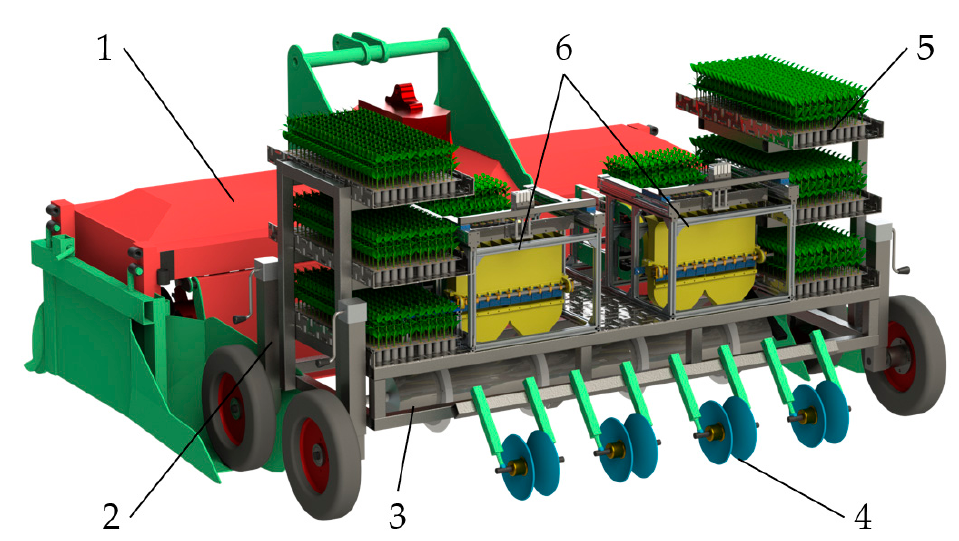
Figure 1. Traction-based automatic pot seedling transplanting machine: (1) Rotary tillage ridging device, (2) height-adjustable frame, (3) rotary ditching device, (4) earthing device, (5) seedling tray frame, (6) automatic seedling feeding device.